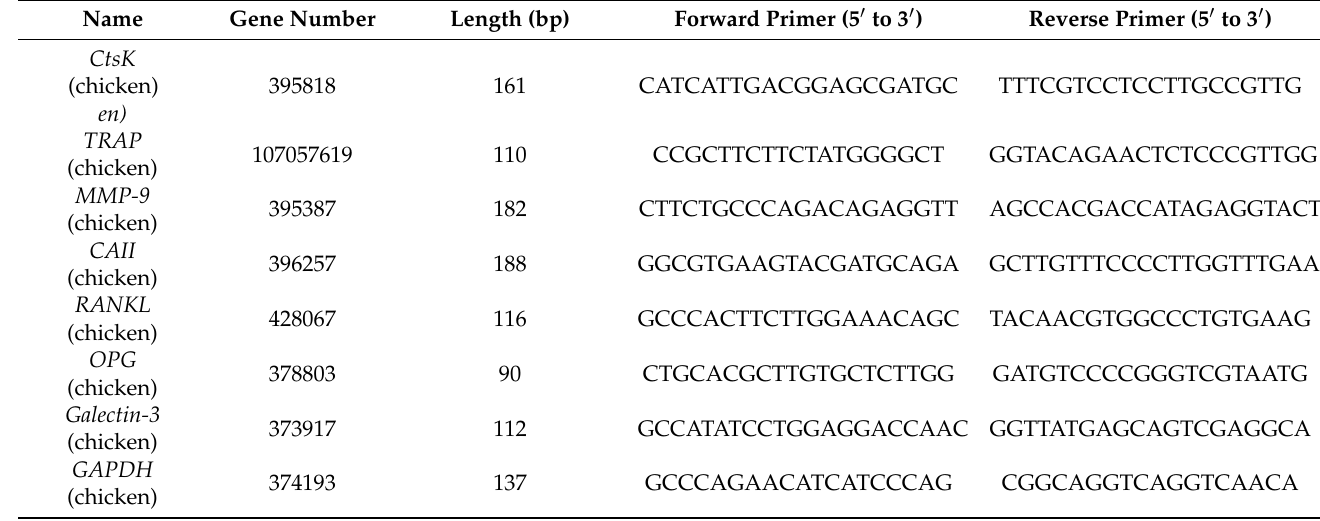
Table 1. Sequences of target